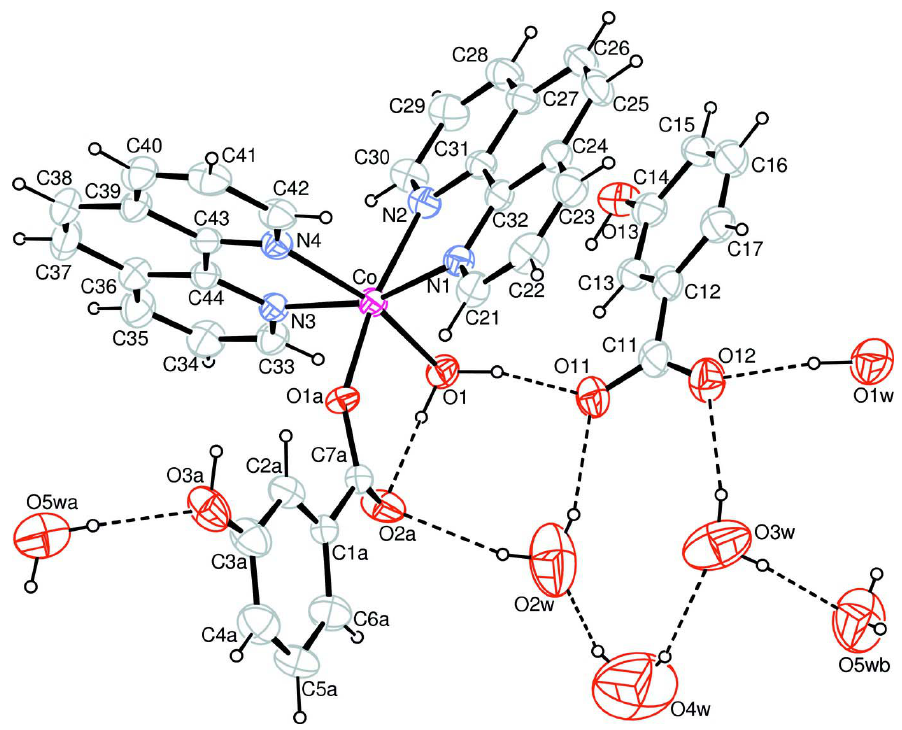
Figure 1 The molecular structure of the title compound with 30% probability displacement (arbitrary spheres for H atoms). One of disordered components has been omitted for clarity.